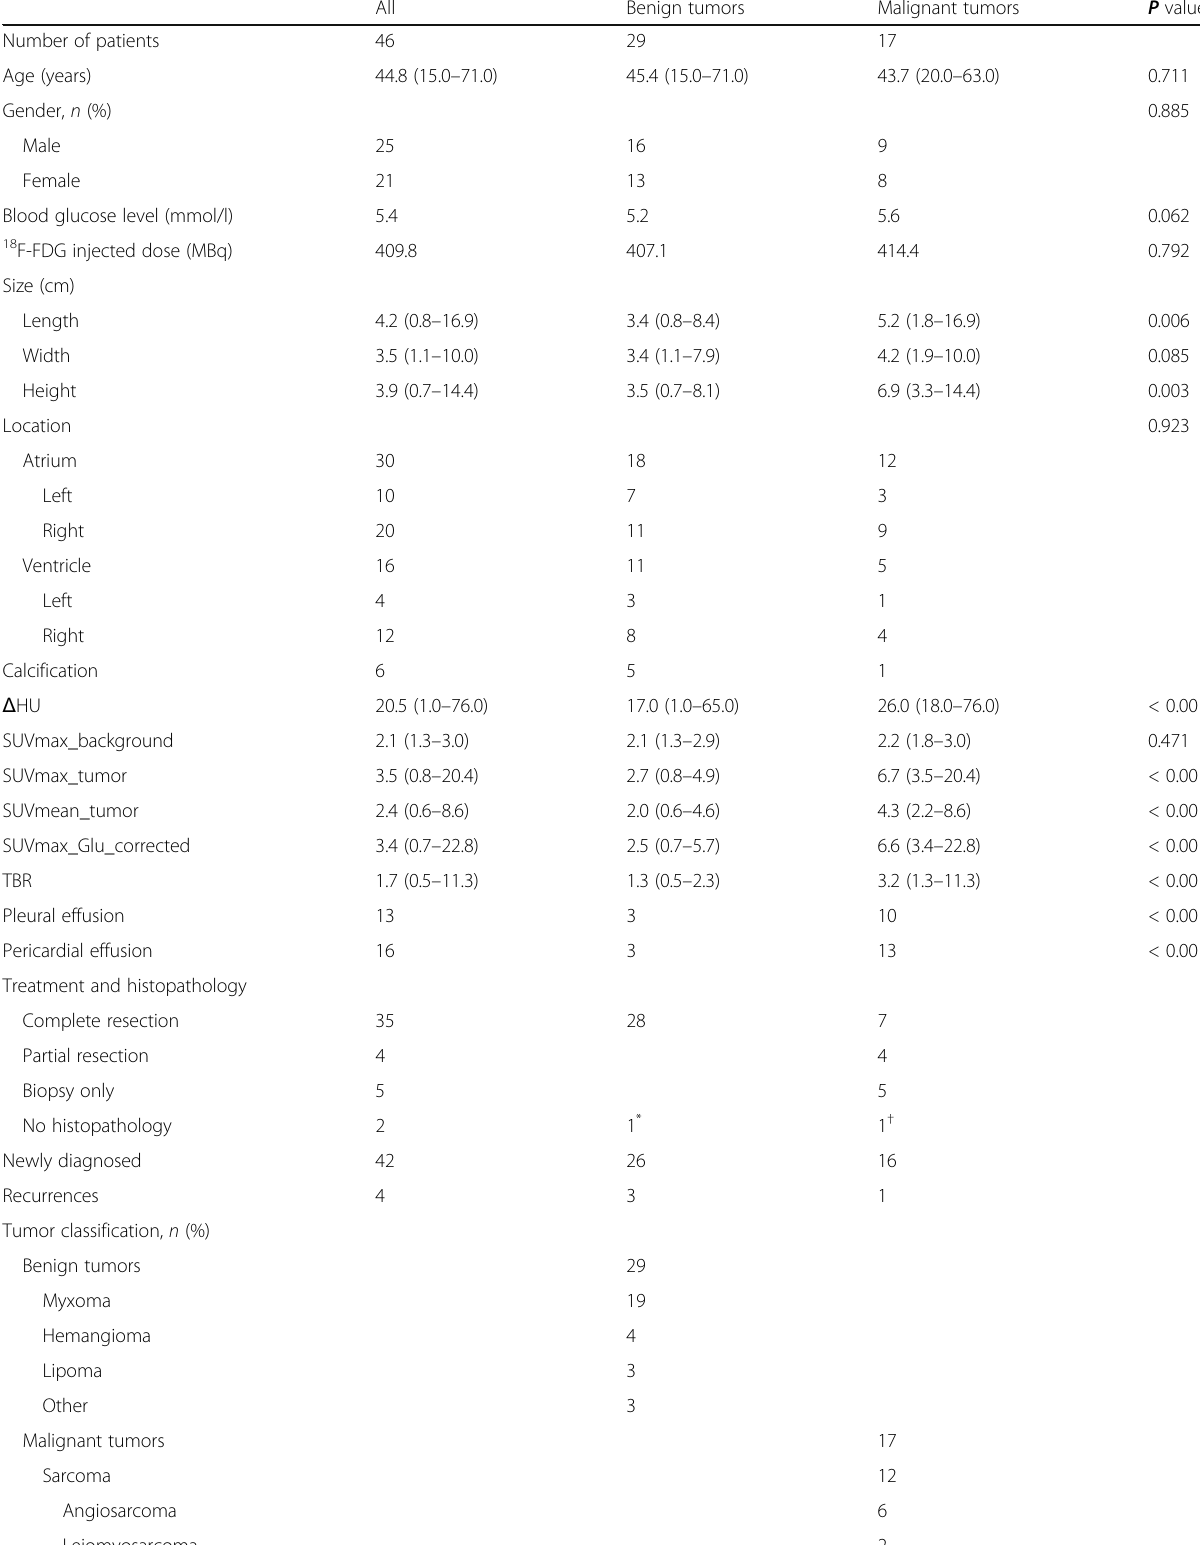
Table 1 Characteristics of patients ( n =